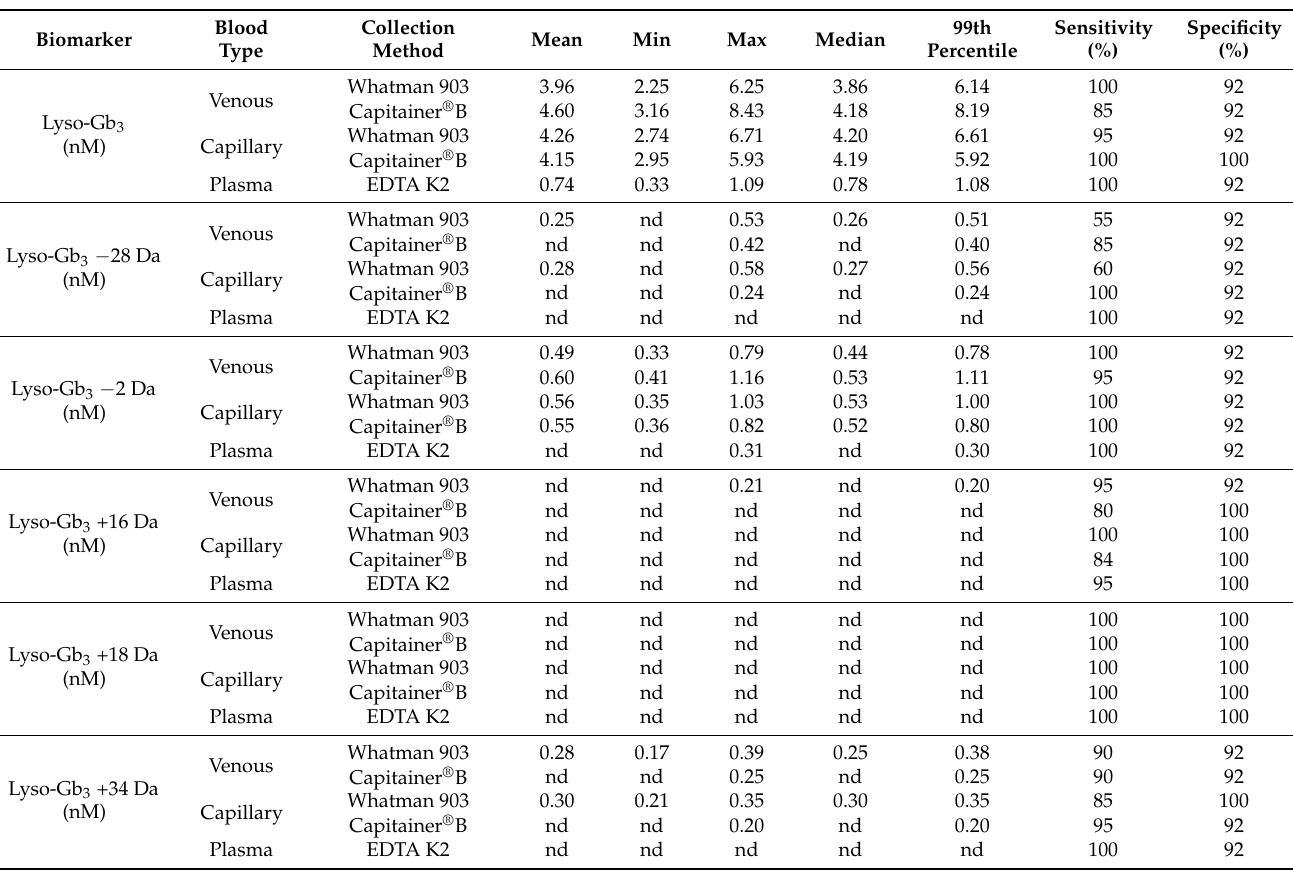
Table 9. Normal reference values (99th percentile) established for each analyte under study following the analysis of DBSs from 12 healthy reference controls. Mean, minimum, maximum, and median values are shown, along with the sensitivity and specificity of the